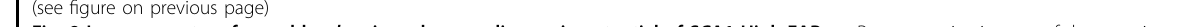
Fig. 8 Immune system from old mdx mice releases adipogenic potential of SCA1-High-FAPs. a Representative images of the experiment whose results are reported in the bar plot in ( b) . FAPs were identi fi ed by an antibody against CD140a (green) and nuclei were counterstained with Hoechst 33342 (blue). Scale bar 40 μ m. b Bar plot representing the number of FAPs (CD140a + cells) per mm 2 in a section of TA from young and old mdx mice. Statistical analysis was carried out by Student ’ s t test ( n = 3). c Representative immuno fl uorescence of TA section of young and old mdx mice showing PPAR-gamma positive FAPs. FAPs were immunolabelled with an antibody against CD140a (green) and nuclei were counterstained with Hoechst 33342 (blue). In red cells expressing PPAR-gamma. Scale bar 40 μ m ( n = 3). d Schematic representation of the experiment in ( e ) and ( f ). Leucocytes (CD45 + cells) were isolated through MACS from young and old mdx mice. After 24 h of ex vivo culture their conditioned media (CM) were harvested and used to induce adipogenesis of young FAP cell states from mdx mice in combination with AIM and MM. Cells and dish are taken from Servier Medical Art (SMART), under Creative Commons Attribution 3.0 Unported License. e Representative microphotographs of (d) . Lipid droplets were stained with ORO (red) and nuclei with Hoechst 33342 (blue). f Bar plot showing the percentage of ORO positive cells (n = 3). Statistical signi fi cance was evaluated using Two-way ANOVA. Scale bar 100 μ m. g Immuno fl uorescence against perilipin on TAs from young (left) and old (right) mdx mice. Representative images of reconstruction of the whole TA section. Perilipin is showed in green and nuclei in blue. Dashed lines highlight section borders. Scale bar 500 μ m. Lower insets show images used to reconstruct the whole muscle. Scale bar 100 μ m. Arrows indicate perilipin positive cells. h Bar plot presenting the percentage of Perilipin positive area in the whole TA section. Statistical signi fi cance was evaluated using Student ’ s t test. n = 3. i Bar plot showing the expression of Cebpb mRNA in the TA of young ( n = 3) and old ( n = 4) mdx mice assessed by Real- Time PCR using 2 - ΔΔ Ct comparative method. Tubulin mRNA was set as reference gene. Statistical signi fi cance was evaluated with Student ’ s t test. Data are presented as mean ± SEM. * p ≤ 0.05, ** p ≤ 0.01, *** p ≤ 0.001, **** p ≤